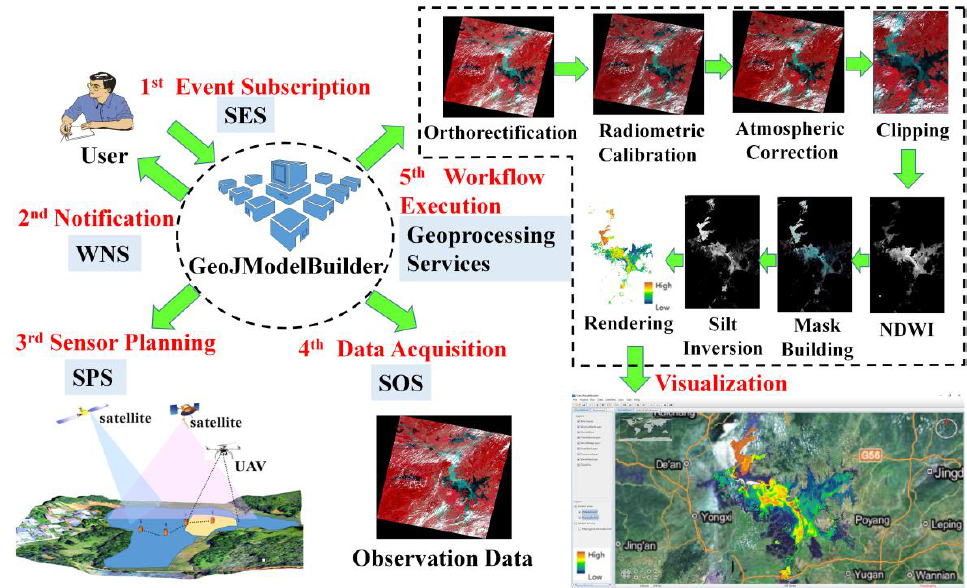
Figure 6. The process of data monitoring and processing for the detection of excessive sediment